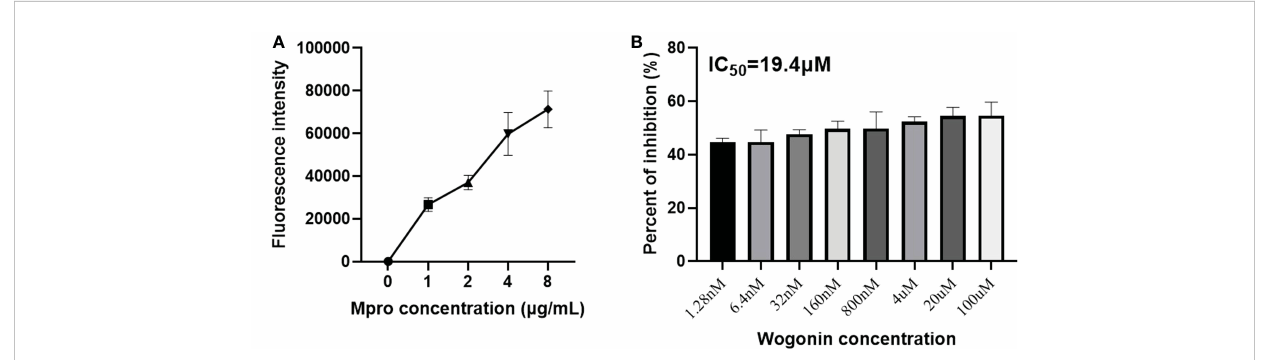
FIGURE 6 Inhibition of the PEDV Mpro enzymatic activity by wogonin. (A) The fl uorescence resonance energy transfer (FRET) assay was performed to analyze the enzymatic activity of the puri fi ed PEDV Mpro. (B) The effect of wogonin on the activity of Mpro by FRET assay. IC50 was determined using GraphPad Prism 6 software. Data are shown as the means ± SD of three independent experiments.